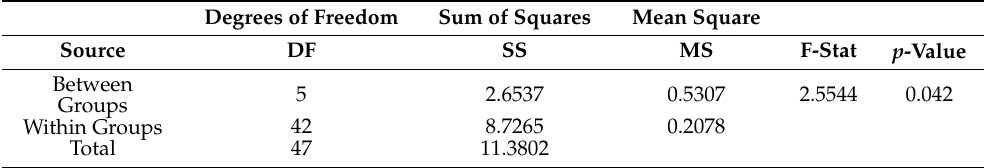
Table 4. Comparison of Contexts for High Sensitivity